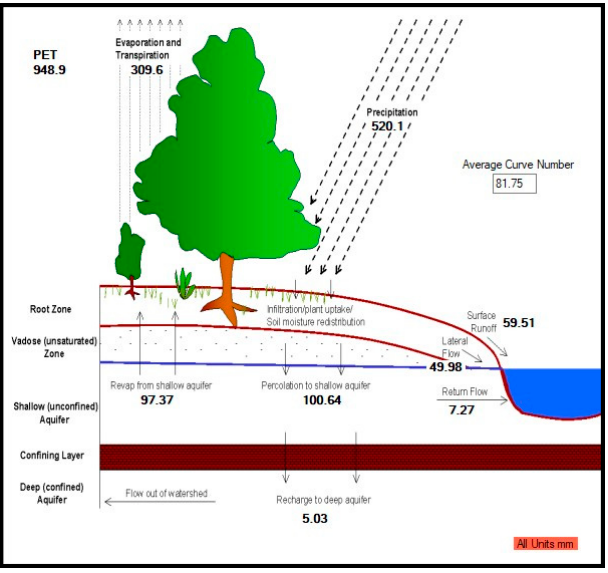
Figure 2. The hydrological procedures of the Havrias river basin for the period 1981–2000